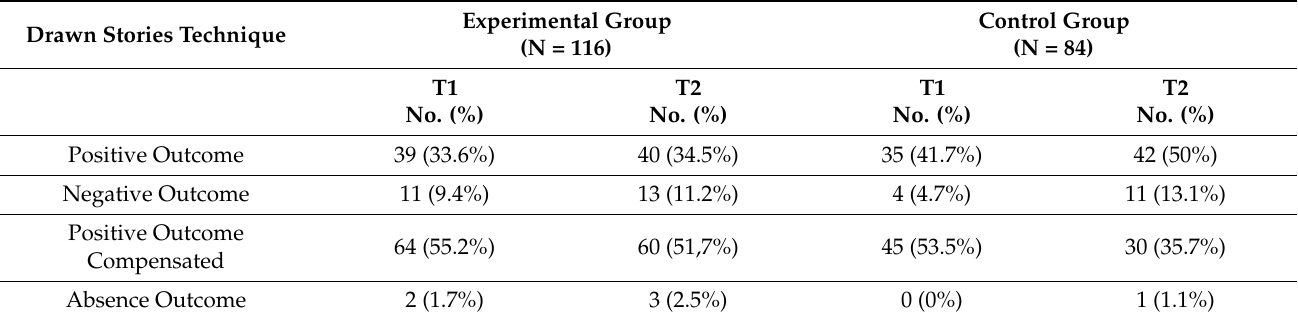
Table 3. Number (%) of children in each Drawn Stories Technique (DST) outcome at baseline (T1) and post-intervention follow-up